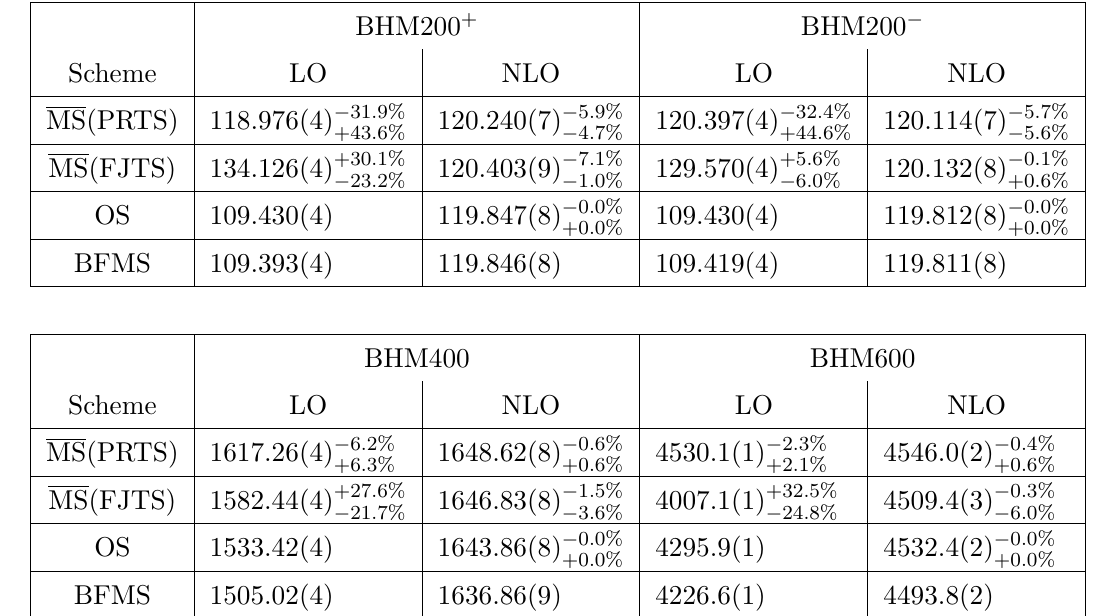
Table 5 . As in table 4, but for the decay width (cid:0) H 1 ! 4 f [MeV] of the heavy HSESM Higgs boson H 1 .